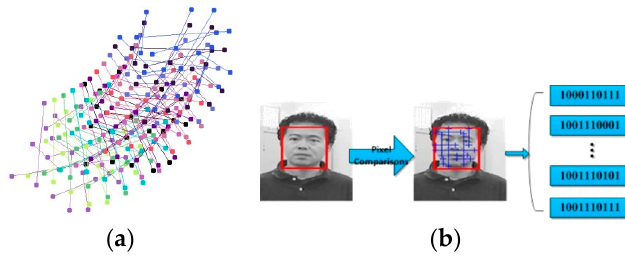
Figure 3. Pixel comparisons and the generation of the feature vectors: ( a ) pixel comparisons; and ( b ) the generation of the feature vectors.